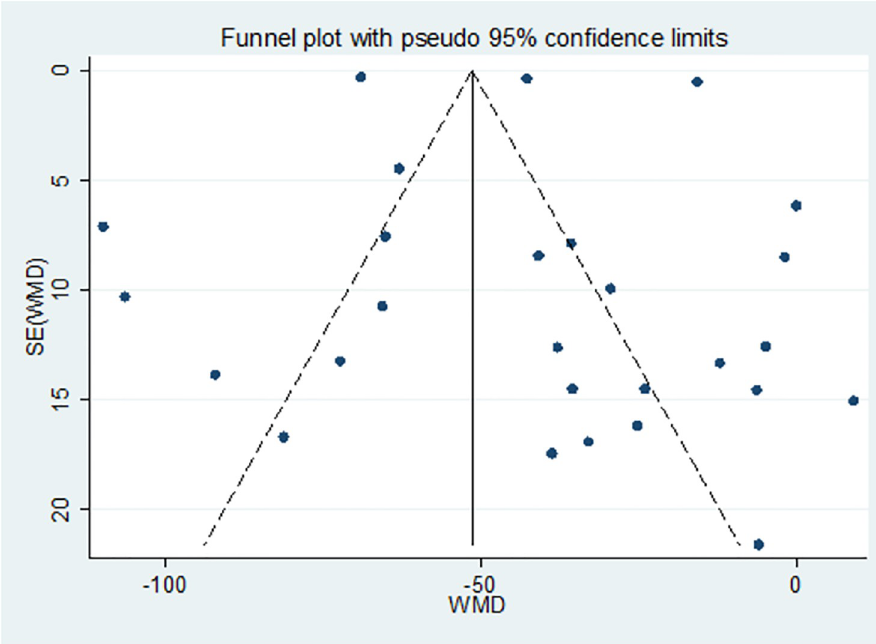
Fig 4. Funnel plot for the pooled WMD estimate of PC between PE and NT